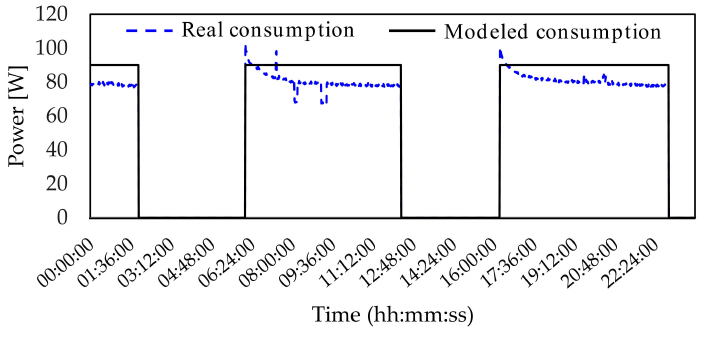
Figure 4. Example of power demand for a